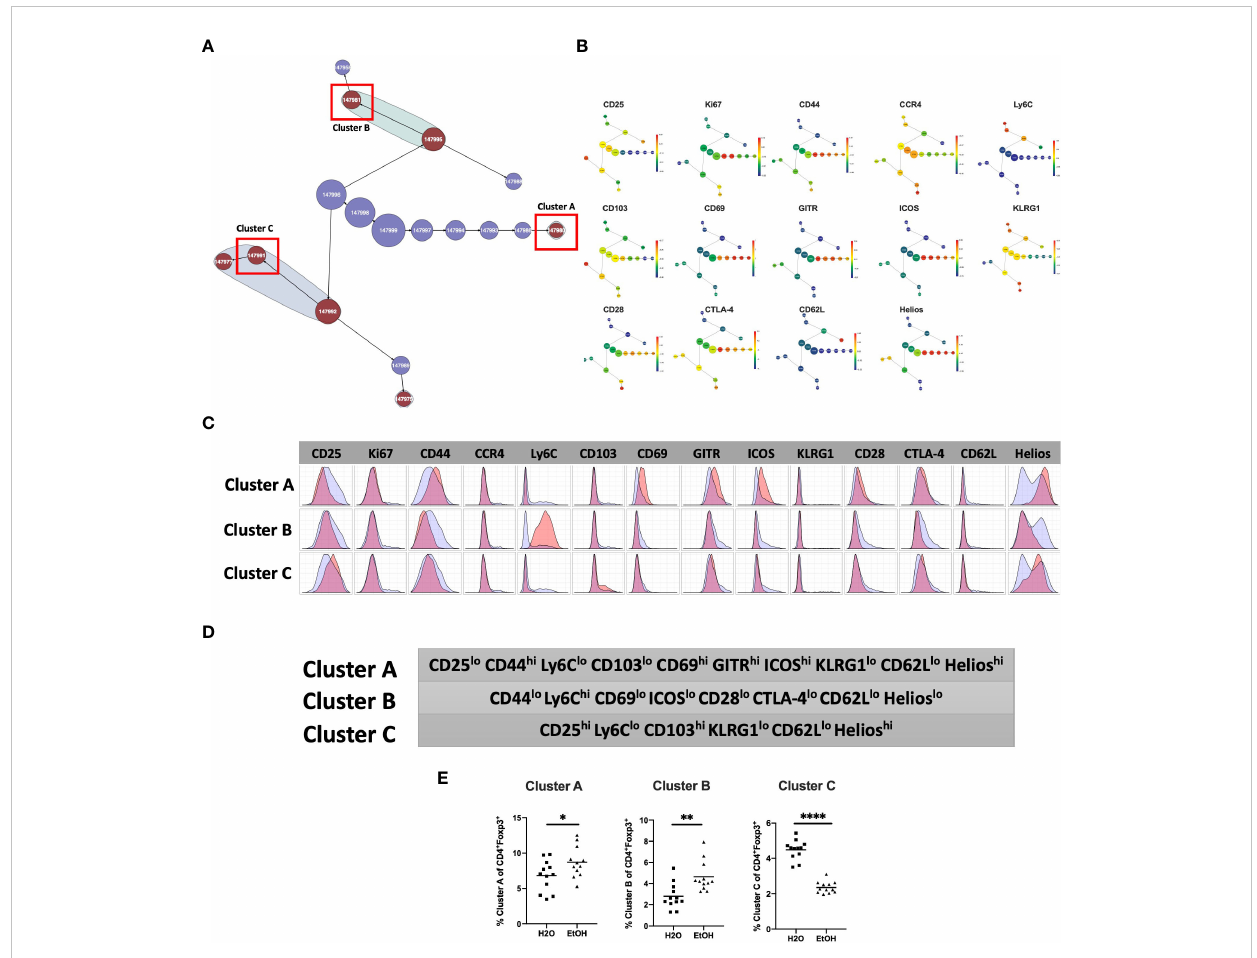
FIGURE 3 Phenotypic analysis of three CD4 + T reg clusters that are signi fi cantly different in water- vs . alcohol-exposed mice. Following CITRUS modeling and identi fi cation of three CD4 + T Reg clusters predictive of alcohol drinking mice, phenotypic cluster characterization was performed by assessing (A) , marker expression on the viSNE map with the overlaid clusters, (B) , CITRUS clusters of interest shown in the feature plots in (A) were compared to expression on corresponding the heatmap marker plots in (B, C) CITRUS marker histogram expression was visualized where blue represents background expression and red represents expression within the cluster of interest. The fi nal phenotypic characterization pro fi le assigned to the three clusters of interest is shown in (D, E) . Manual gating demonstrated that the statistical frequencies of Clusters (A) (8.7 ± 0.6% vs . 6.8 ± 0.6%, p=0.04) and (B) (4.6 ± 0.4% vs .2.8 ± .3%, p=0.002) were increased in alcohol exposed mice, while the frequency of Cluster (C) (2.4 ± 0.1% vs . 4.5 ± 0.2%, p <0.0001) was decreased. Data were tested for normality and compared with either t test or Mann-Whitney test. *p<0.05,